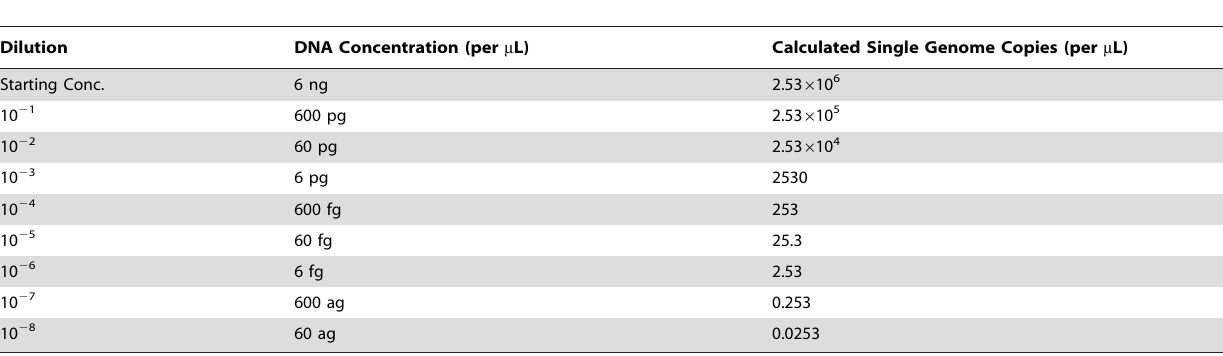
Table 1. Serial dilutions of meningococcal extracts, corresponding estimated DNA concentration and calculated genome copy number (estimate based upon a 2.2 Mbp genome).